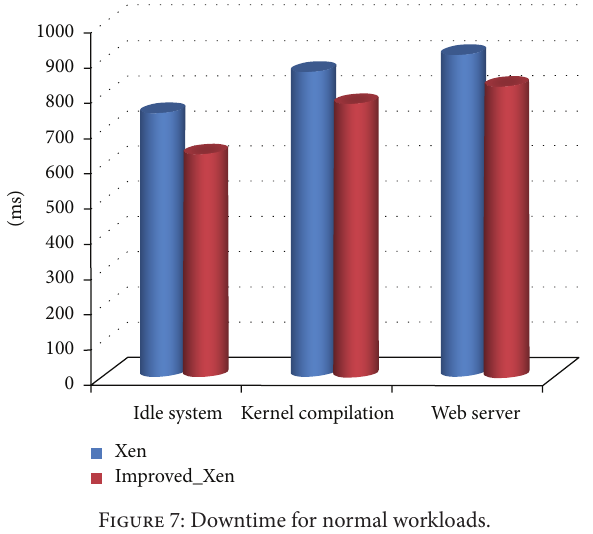
Figure 7: Downtime for normal workloads.